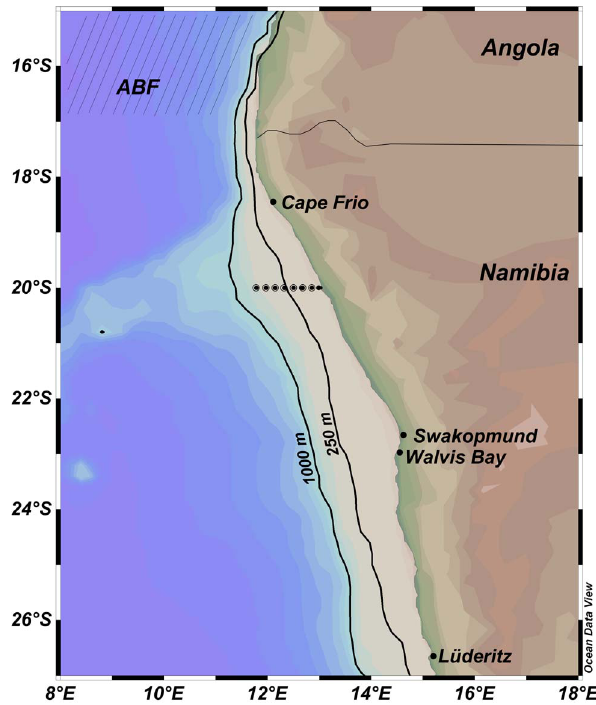
Figure 1. Location of the monitoring transect at 20 6 S off Namibia and approximate position of the Angola Benguela Front (ABF).